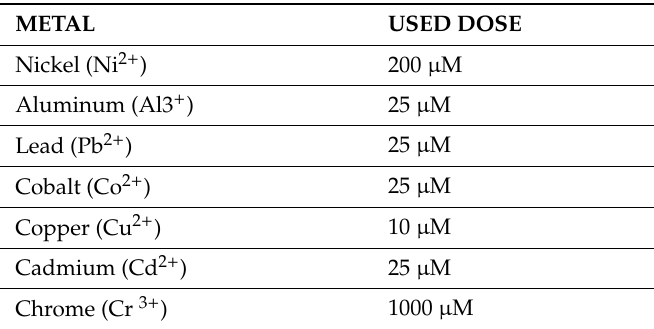
Table 1. The selected concentrations for each heavy